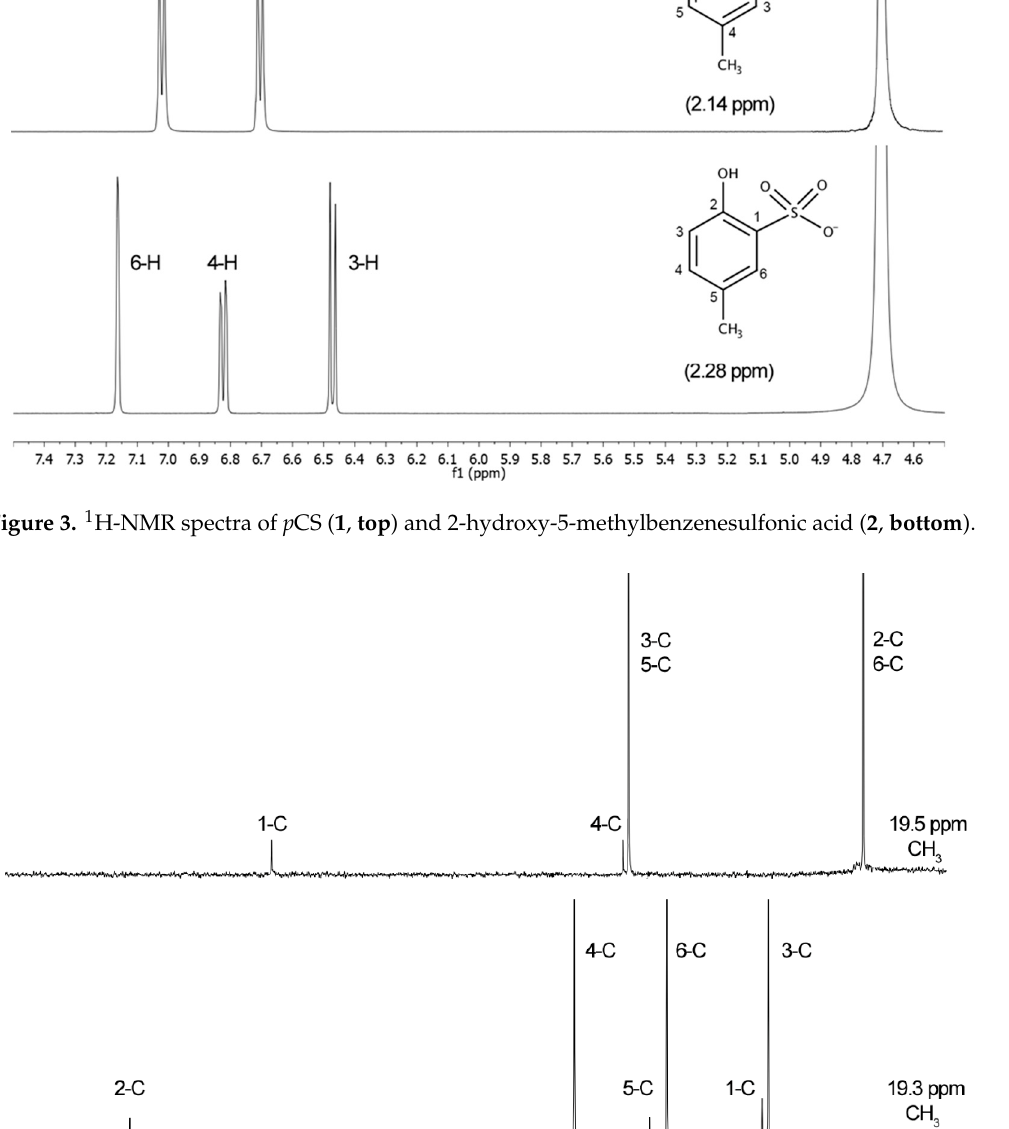
Figure 3. 1 H-NMR spectra of p CS ( 1 , top ) and 2-hydroxy-5-methylbenzenesulfonic acid ( 2 , bottom ).